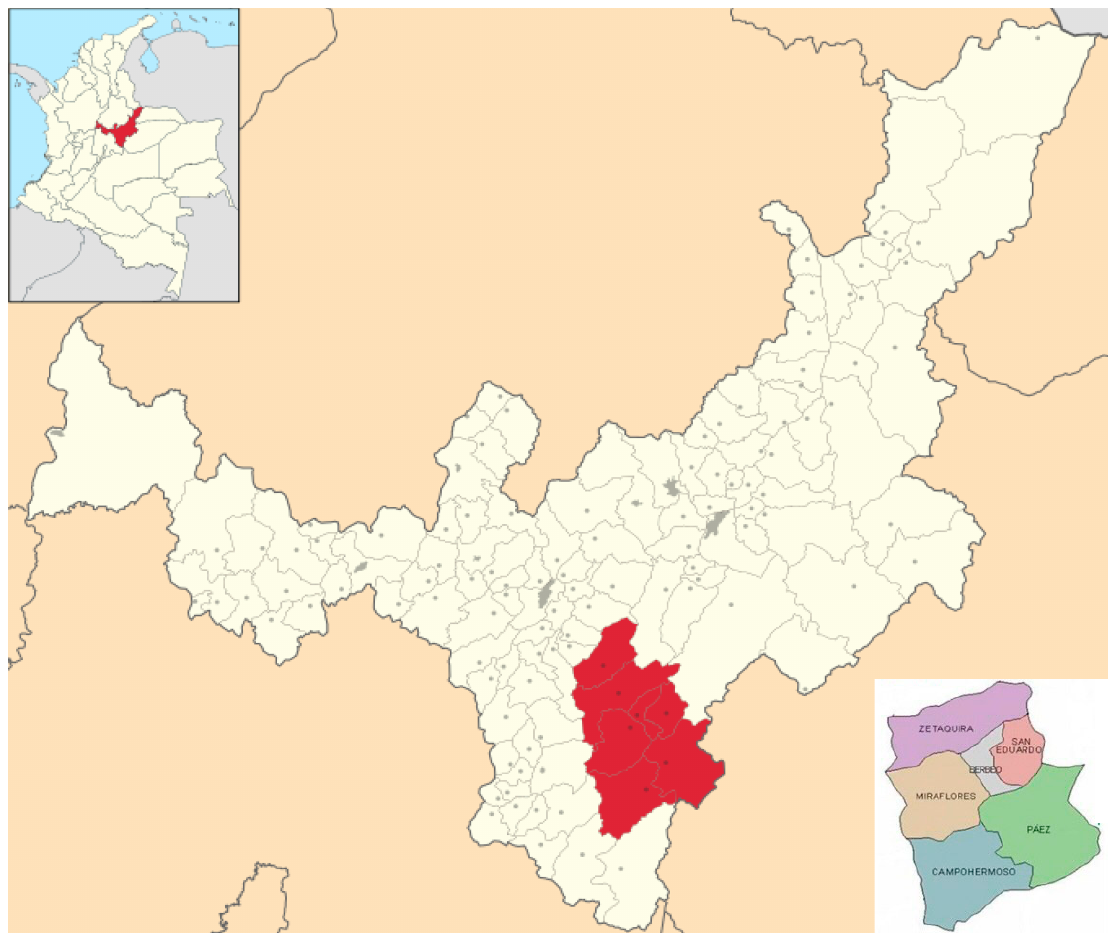
Figure 6. Geographic location of the province of Lengupá (Boyacá) Colombia and its municipalities. Qualitative and quantitative descriptors were evaluated for cladodes, fruits, and covered production systems. In total, seven characteristics were recorded in the characteri- zation of the cladodes: one quantitative and six qualitative (Table 4). Measurements were